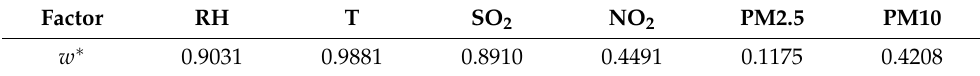
Table 5. The importance of each atmospheric factor in Stage 1 (after 550 hours of exposure).